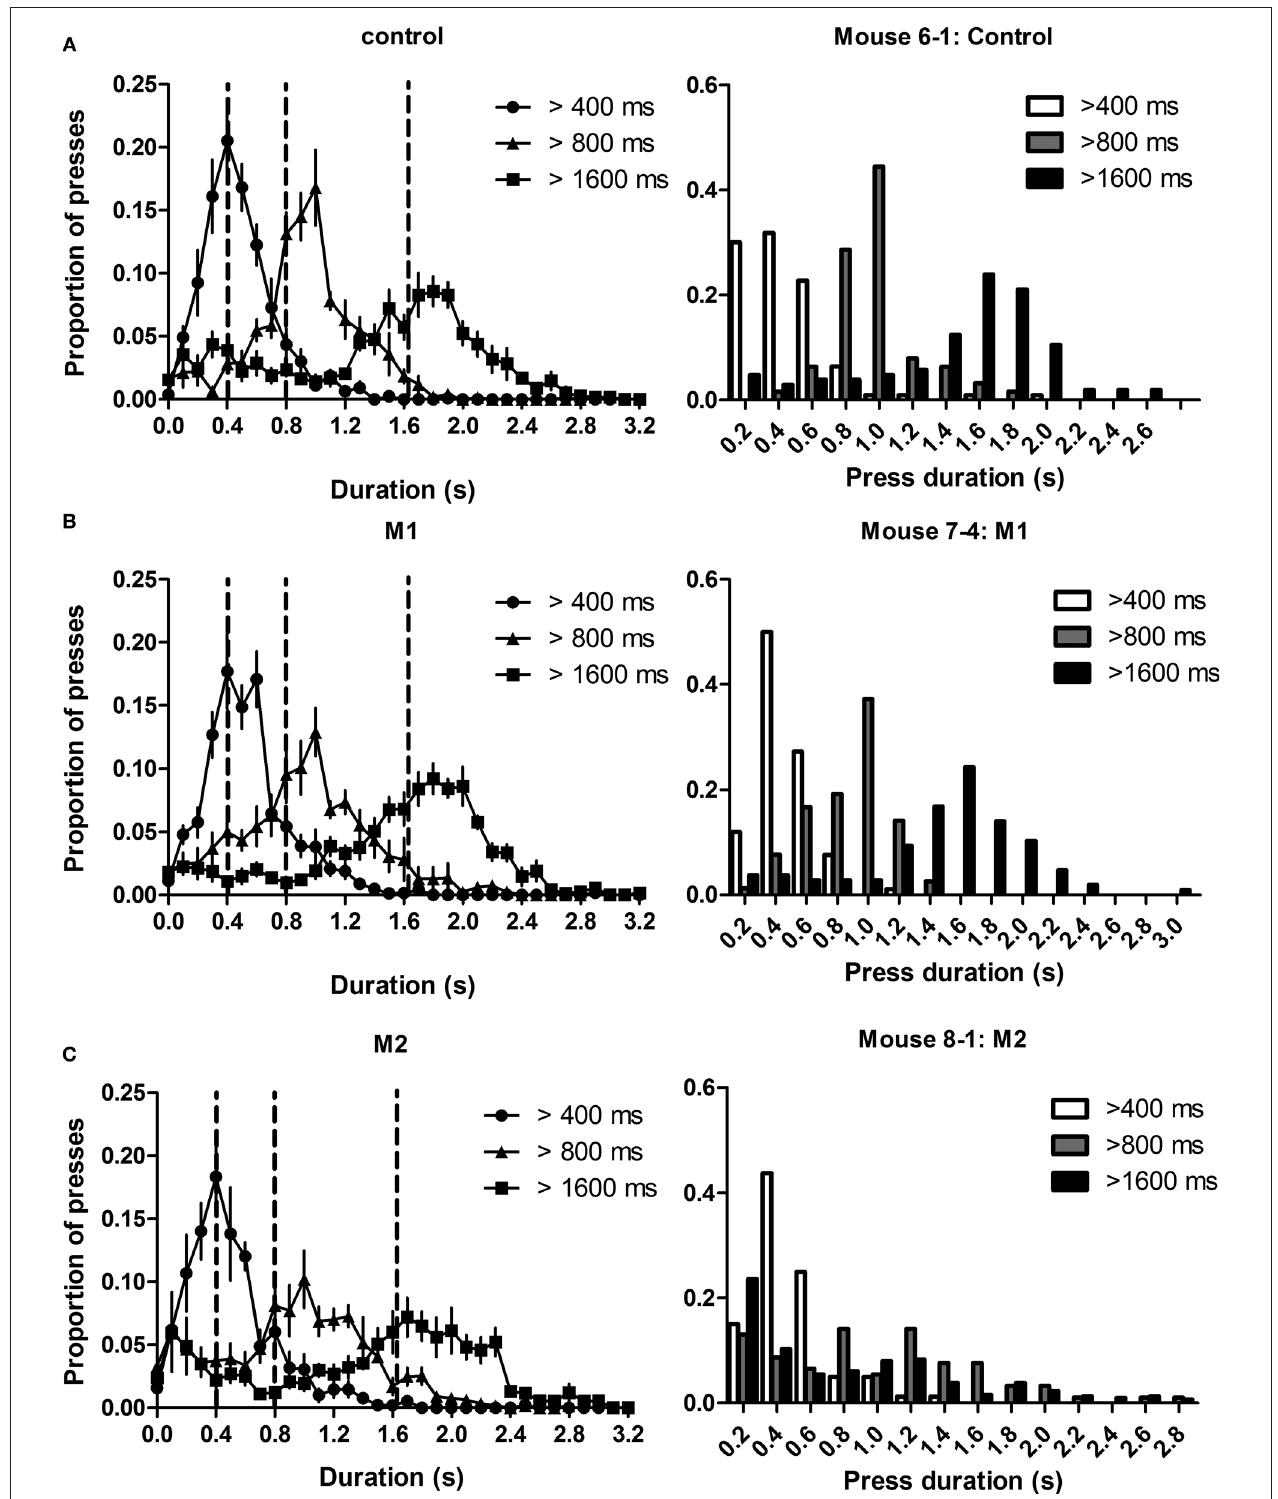
FIgure  | Lever press durations of mice are scalar. The left panels show ‘steady-state’ distributions of press durations during the last session of training for all three duration criteria. The spread of these distributions is proportional to the average, exhibiting Weber’s law. Dotted lines indicate the criterion durations. The right panels show individual examples. (A) Distributions of press durations for controls. (B) Distributions of press durations for Group M1. (C) Distributions of press durations for Group